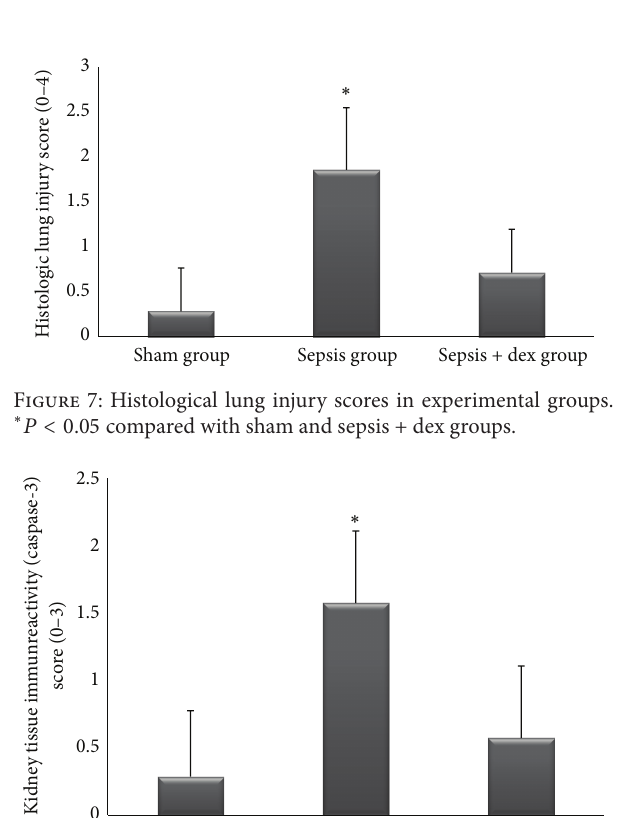
Figure 8: Kidney tissue immunoreactivity scores in experimental groups. ∗ 𝑃 < 0.05 compared with sham and sepsis + dex groups.